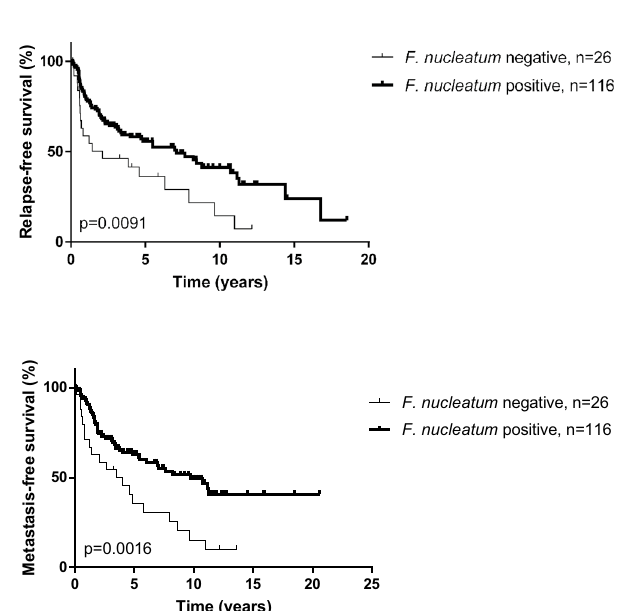
Figure 3. Relapse-free (RFS) ( A ) and metastasis-free survival (MFS) ( B ) curves according to F. nucleatum status in the merged cohort (N = 142 evaluable patients).